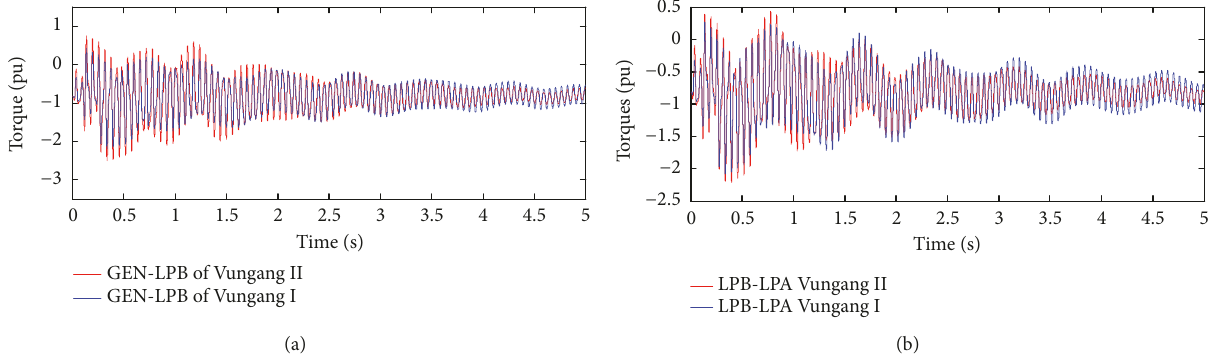
Figure 18: The effect of the STATCOM on the SSR of Vungang I and II plants: (a) The torque oscillation in LPA-LPB shaft section of Vungang I plant’s unit 1 and Vungang I plant’s unit 2 under considering Scenario 1. (b) The torque oscillation in LPA-LPB shaft section of Vungang II plant’s unit 1 and Vungang I plant’s unit 2 under considering Scenario 2.